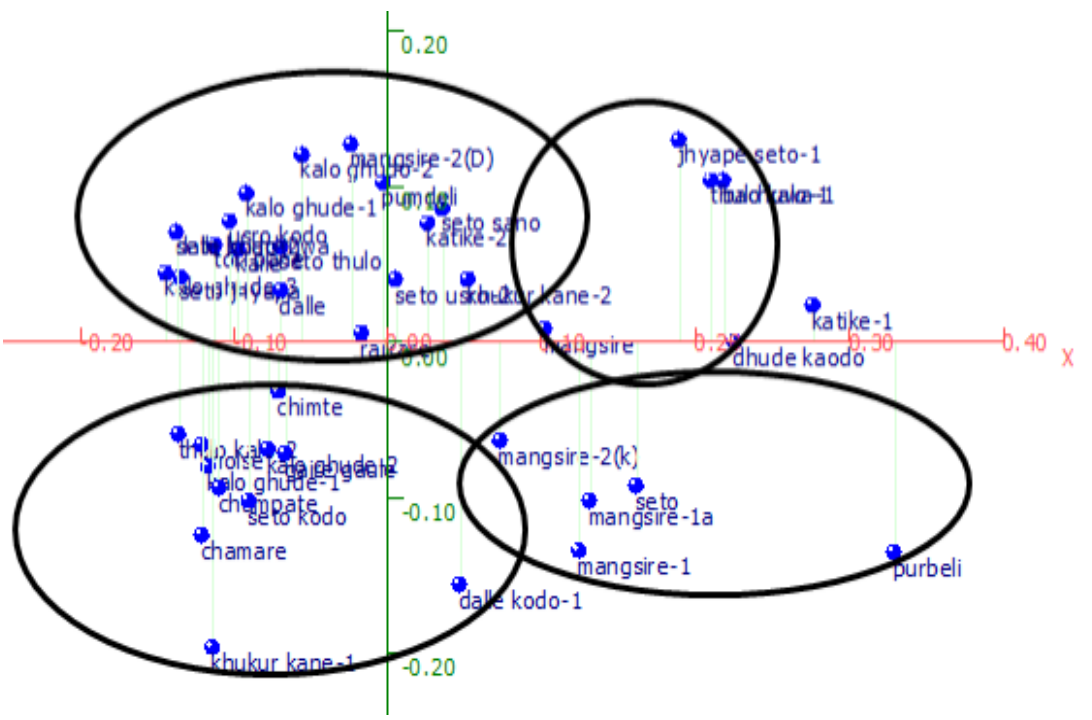
Figure 5 . Scatter plot of 40 finger millet landraces based on 9 RAPD